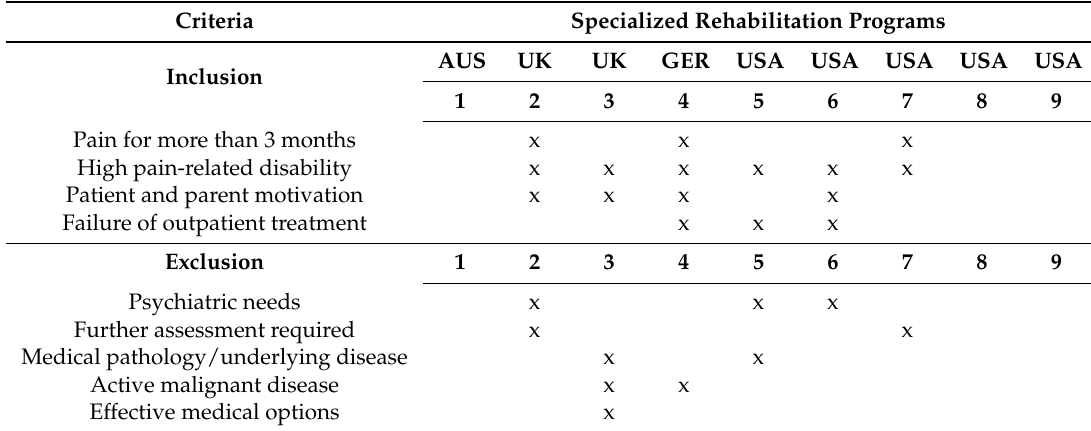
Table 1. Admission criteria for specialized rehabilitation